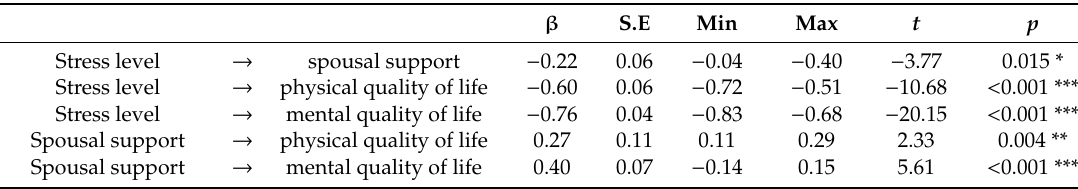
Table 4. Path coe ffi cient analysis results of internal model.